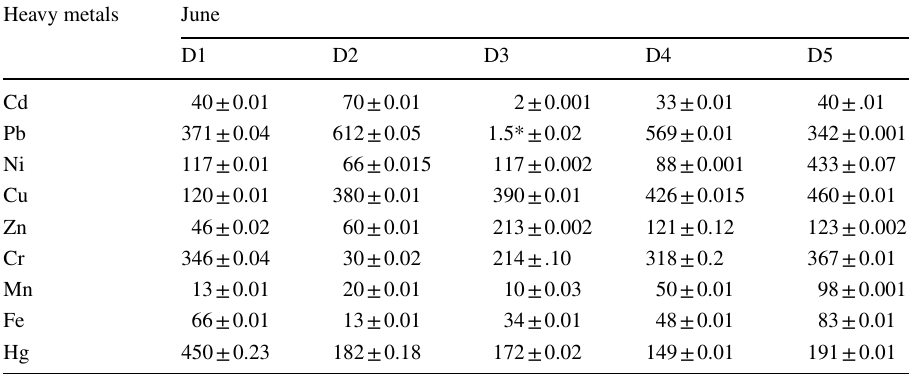
All the heavy metal units are in µg/L; only